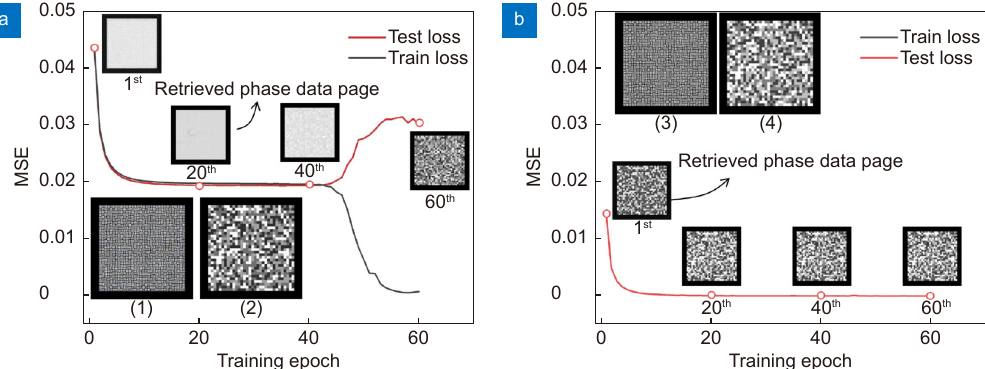
Fig. 6 | Change in the MSE using two different phase encoding datasets with ( a ) (0, π/2, π, 3π/2) and ( b ) (π/6, 2π/3, π, 3π/2) when training the same neural network. (1) and (3) are the same intensity images fed to the CNN and (2) and (4) are the ground truth of the phase data page. The pages at the 1 st , 20 th , 40 th , and 60 th epoch are the phase data page retrieved from the intensity image using the trained